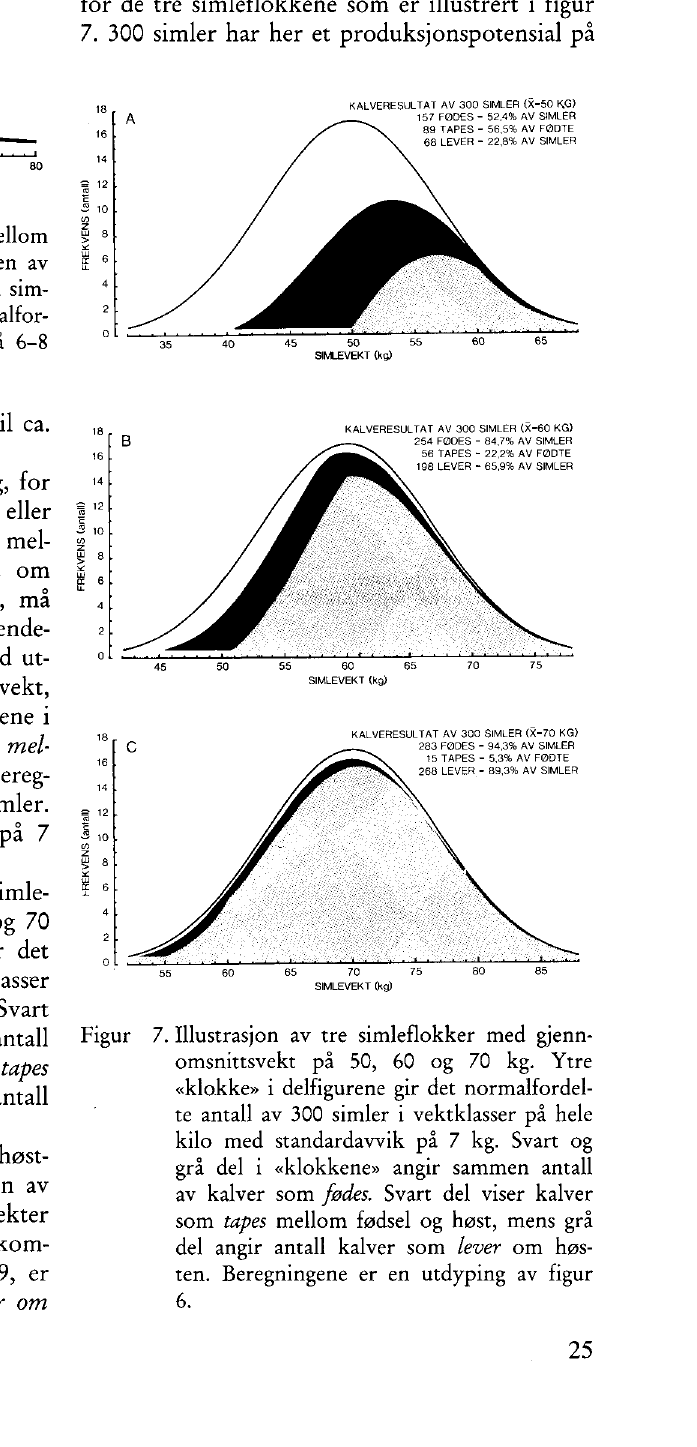
(figur 7) og vist for flokker på 100 simler i fi gur 10. Beregningsresultatene, med et standard avvik på 7 kg for simlevekten, er også gitt i ta bell 1. Med data fra tabell 1 (figur 10) kan produk sjonspotensialet beregnes som kilo kalvekjøtt for de tre simleflokkene som er illustrert i figur 7. 300 simler har her et produksjonspotensial på